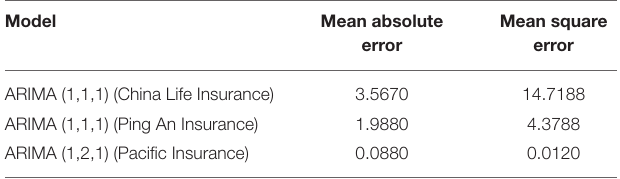
TABLE 3 | Prediction effect of the autoregressive integrated moving average (ARIMA)